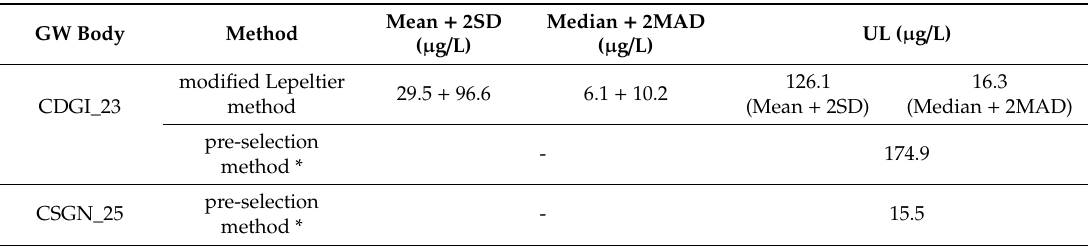
Table 4. Estimated Mean + 2SD and Median + 2MAD ranges (for modified Lepeltier method) and the upper limits of ranges of ambient background concentrations (UL) of arsenic (As) obtained by selected methods. EU Drinking Water Standard for As is 10 µ g /